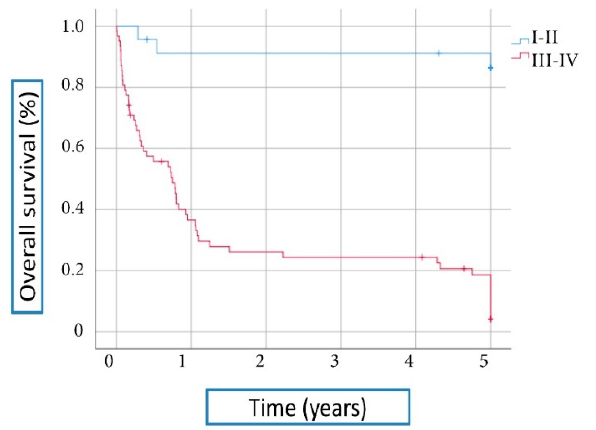
Figure 3. Overall survival rate based on diagnostic stage (stage I–II vs. stage III–IV). There is a significant difference in the 5-year survival rate: stage I-II 87% vs. stage III-IV 11.3%, p = 0.0001.